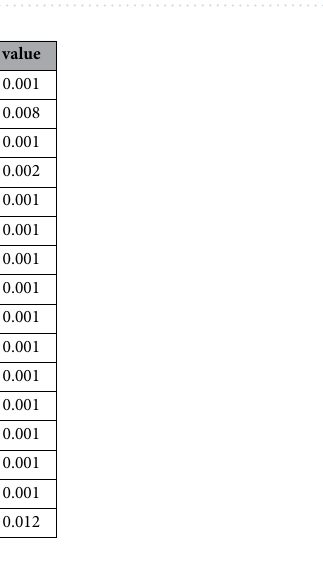
Table 9. Linear regression analysis of different genes.